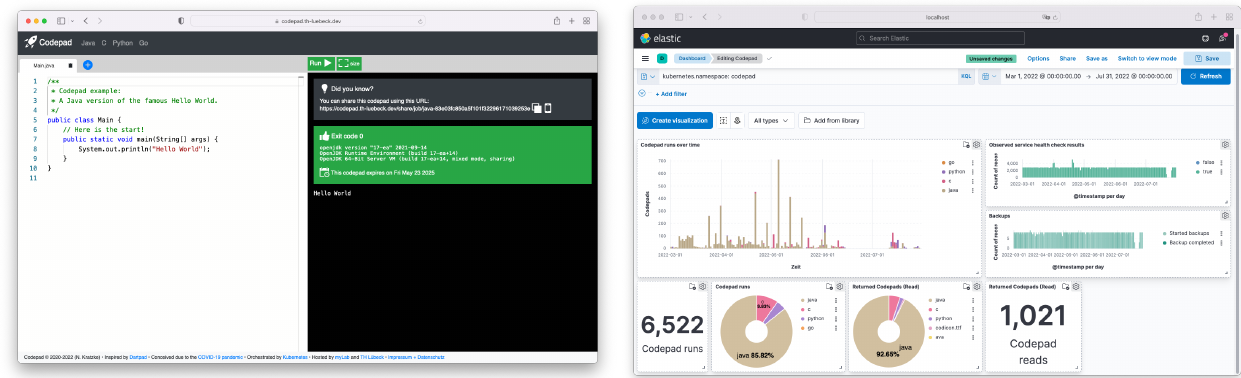
Figure 5. Use Cases 1 and 2: Codepad is an online coding tool to share quickly short code snippets in online and offline teaching scenarios—on the left, the Web-UI; on the right, the Kibana Dashboard used for observability in this study. Codepad was used as an instrumentation object of